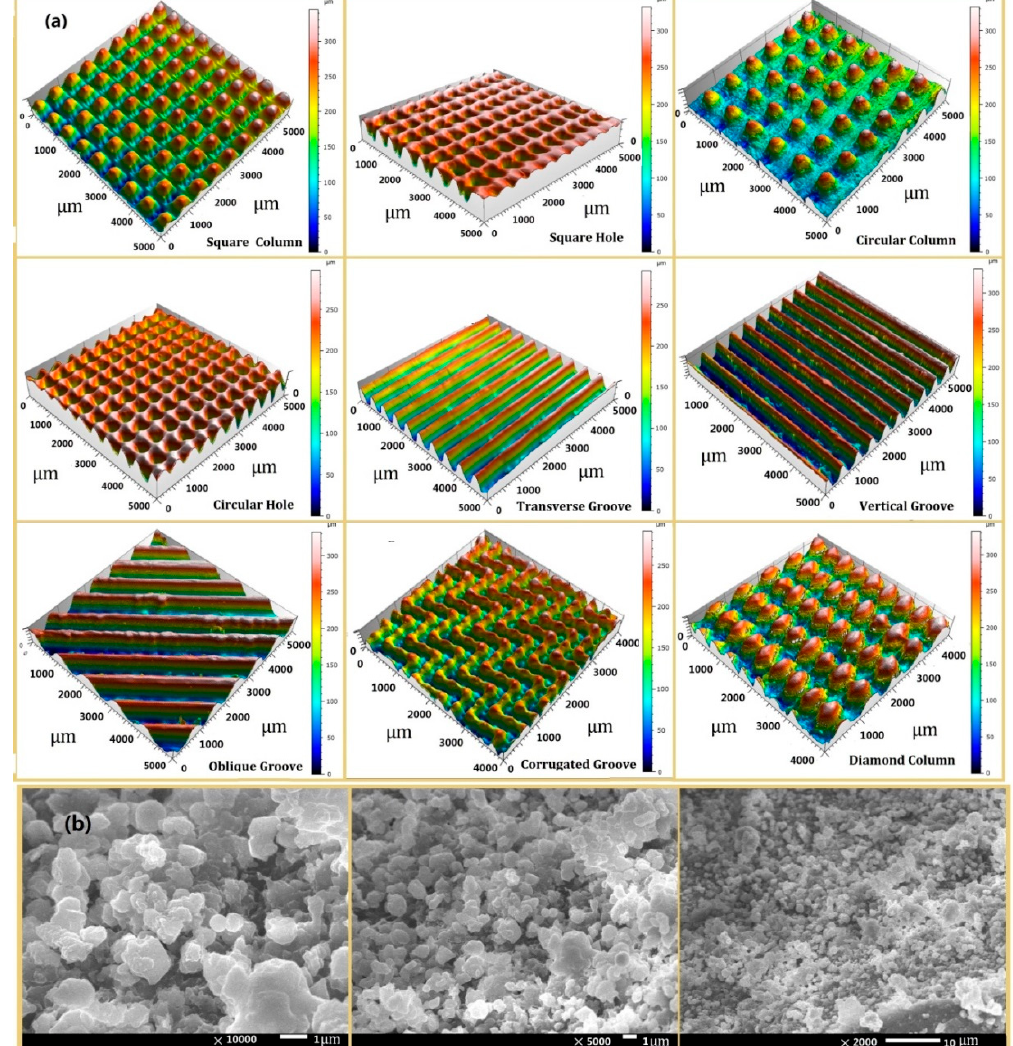
Figure 4. Surface morphology of ( a ) nine textured surface designs and ( b ) SEM images of the square column texture surface. Table 1. The optimal parameters of the surface texture designs with the best hydrophobicity.